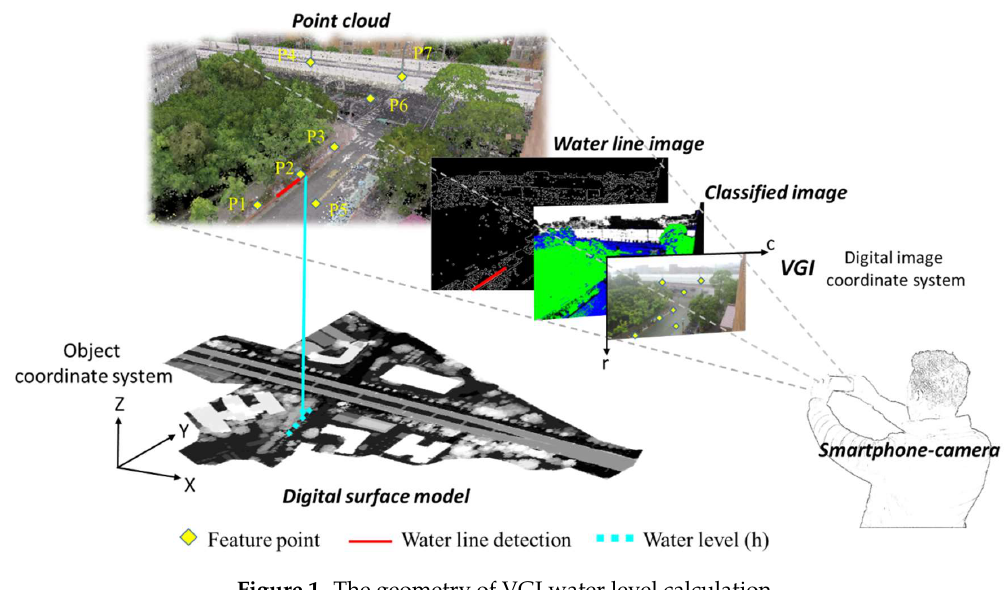
Figure 1. The geometry of VGI water level calculation.